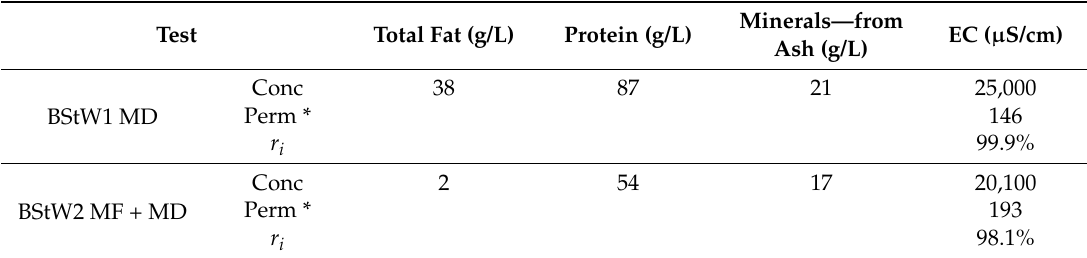
Table 6. BStW MD separation results of measured components using the PU-PTFE membrane, with either BStW1, or after MMF of BStW2. Original stick water properties shown in Table 1. Minerals—from EC ( µ S/cm) Test Total Fat (g/L) Protein (g/L) Ash (g/L) Conc 38 87 21 25,000 Perm * 146 BStW1 MD r i 99.9% Conc 2 54 17 20,100 Perm * 193 BStW2 MF + MD